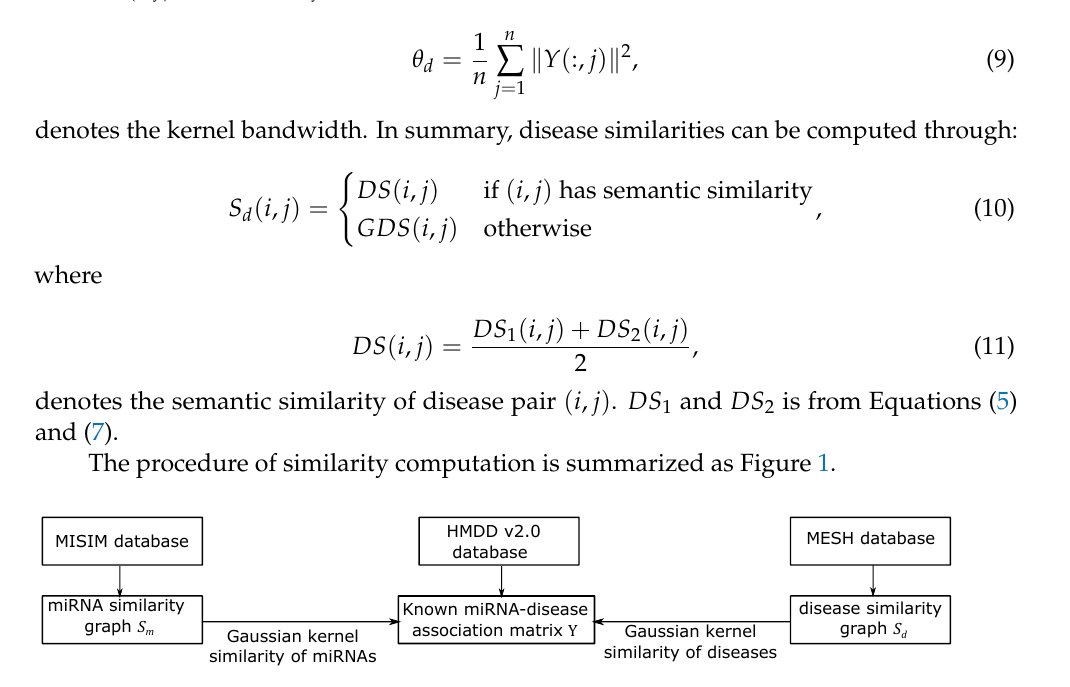
Figure 1. Flowchart of similarity